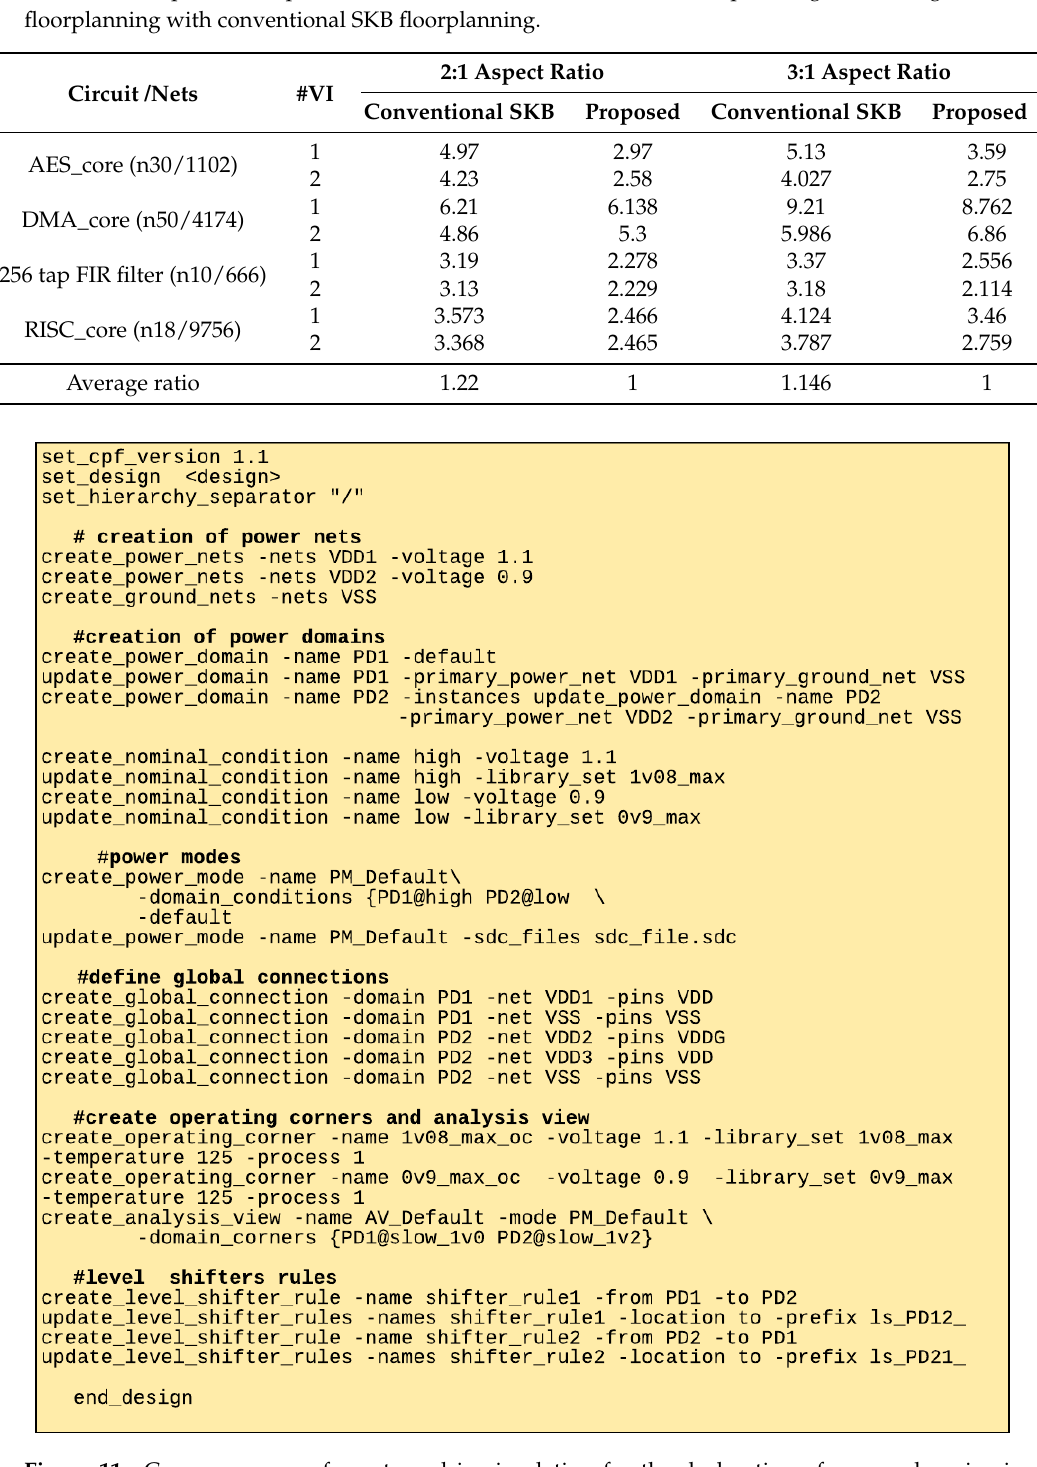
Figure 11. Common power format used in simulation for the declaration of power domains in the